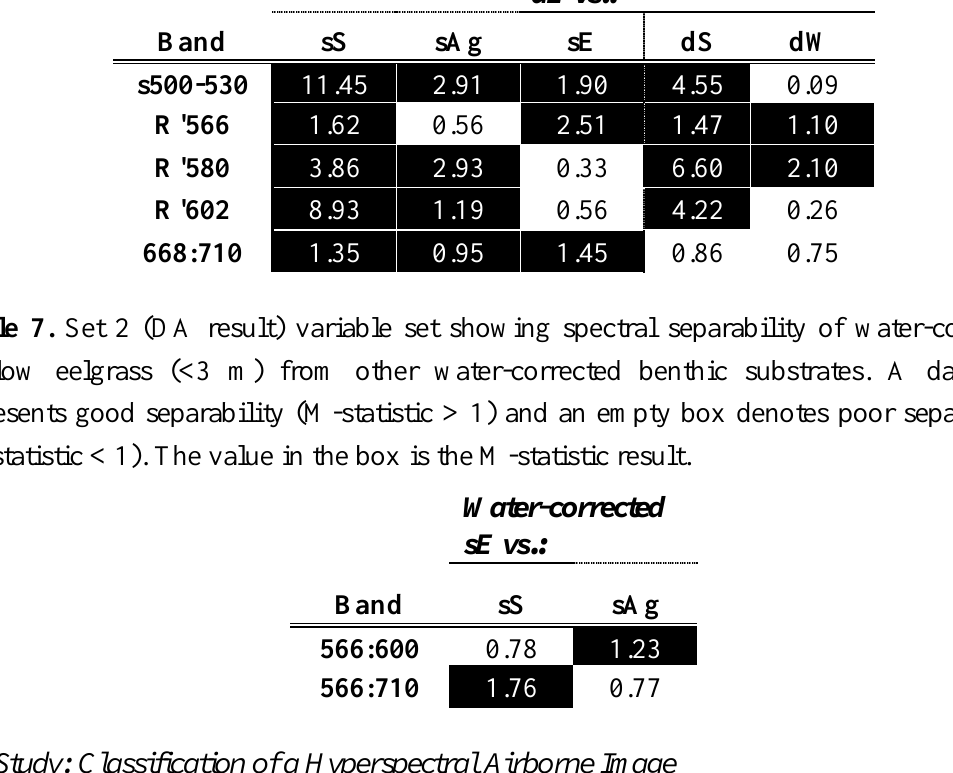
Table 6. Set 2 (DA result) variable set showing spectral separability of deep eelgrass (>3 m) from other benthic substrates from above water. A dark box represents good separability (M-statistic > 1) and an empty box denotes poor separability (M-statistic < 1). The value in the box is the M-statistic result. dE vs.: